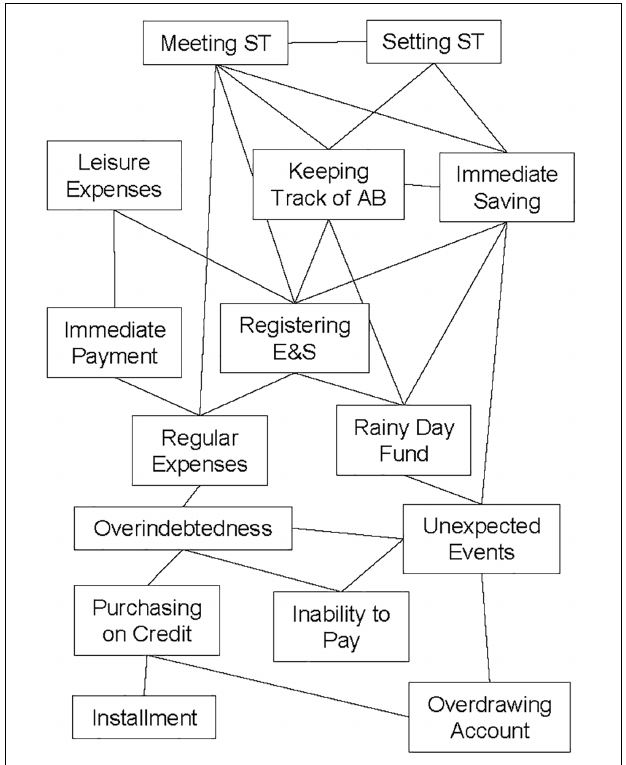
FIGURE 3 | Referent network structure of practical money skills. ST, savings target; E&S, earnings and spending; AB, account